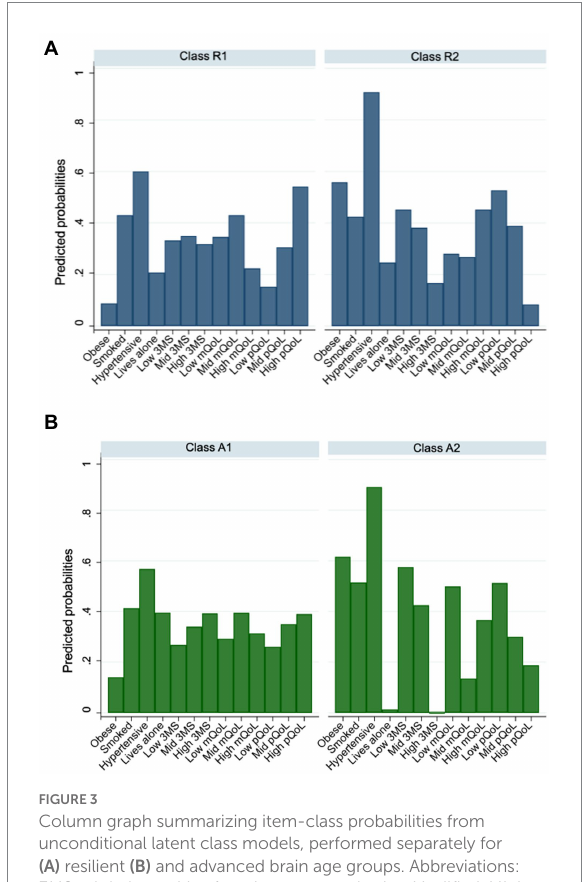
FIGURE 3 Column graph summarizing item-class probabilities from unconditional latent class models, performed separately for (A) resilient (B) and advanced brain age groups. Abbreviations: 3MS = global cognitive function measured using Modified-Mini- Mental State (3MS) examination score (Teng and Chui, 1987); mQoL = mental quality of life; pQoL = physical quality of